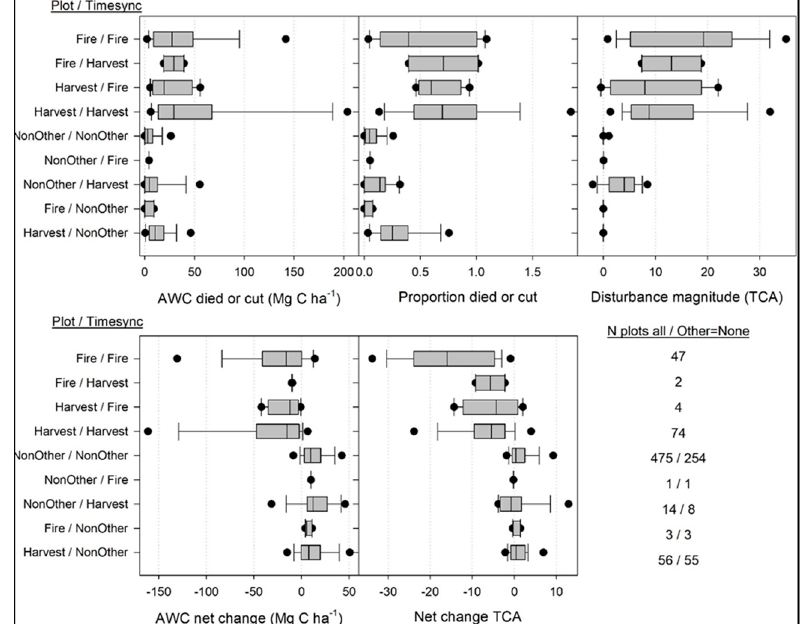
Figure 3. The distribution of changes in plot- and TimeSync-measured metrics by how disturbances were classified with either approach. All nonfire and nonharvest disturbances (including “none”) are included in NonOther in this analysis. Sample sizes for each plot/TimeSync category are shown in the lower right, with the number of records included in the “NonOther” class that were “none” broken out. Boxes consist of the interquartile range with the median shown as a line, whiskers are the 10th and 90th percentiles, and dots are the 5th and 95th